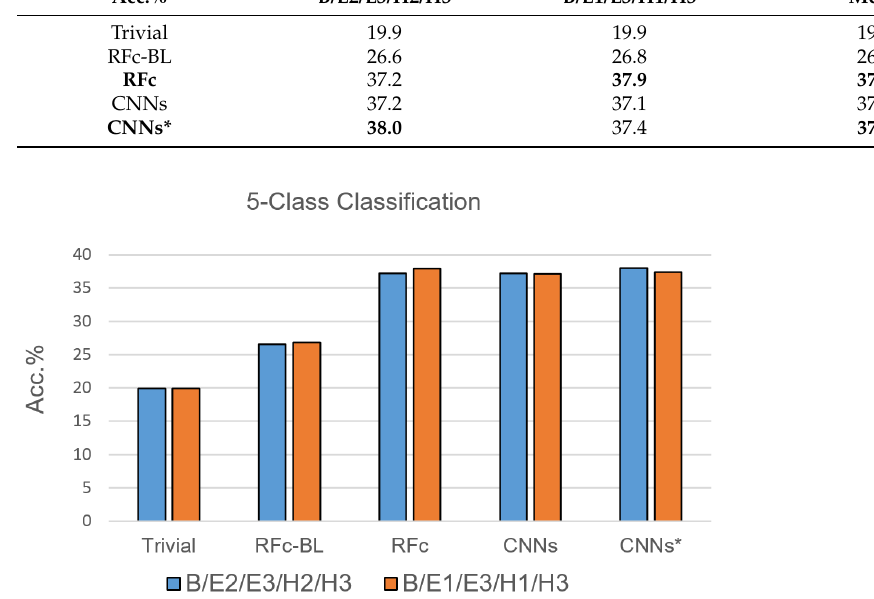
Figure 7. Recognition models for 5-class classification tasks compared to trivial and baseline models.